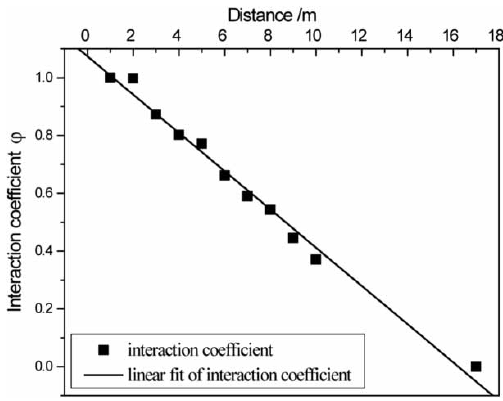
Fig. 12. Linear fit of interaction coefficient between the outer wall and the inner